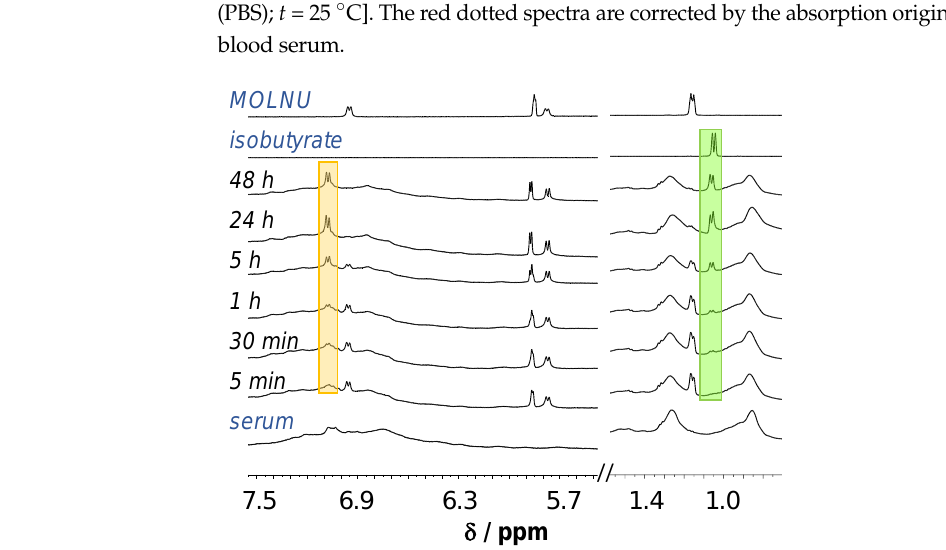
Figure 7. 1 H NMR spectra of MOLNU—blood serum system followed in time, colored frames denote the peaks of the hydrolyzed products EIDD-1931 (yellow) and isobutyrate (green); spectra of blood serum, MOLNU and isobutyrate are shown as well [ c MOLNU = 1 mM; blood serum: 2-fold diluted; c isbobutyrate = 1 mM; pH = 7.4 (PBS), 10% ( v / v ) D 2 O/H 2 O; t = 25 °C].